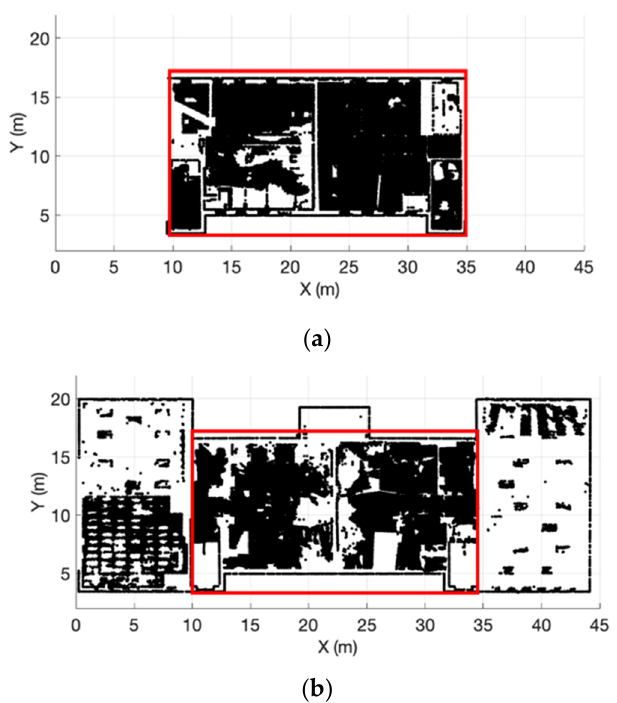
Figure 5. Boundary matching: ( a ) Extracted ceiling slab in black with calculated boundary in red; ( b ) Matched boundary on floor slab in red outline. Points in ( b ) outside of the red outline will be removed from the floor slab.